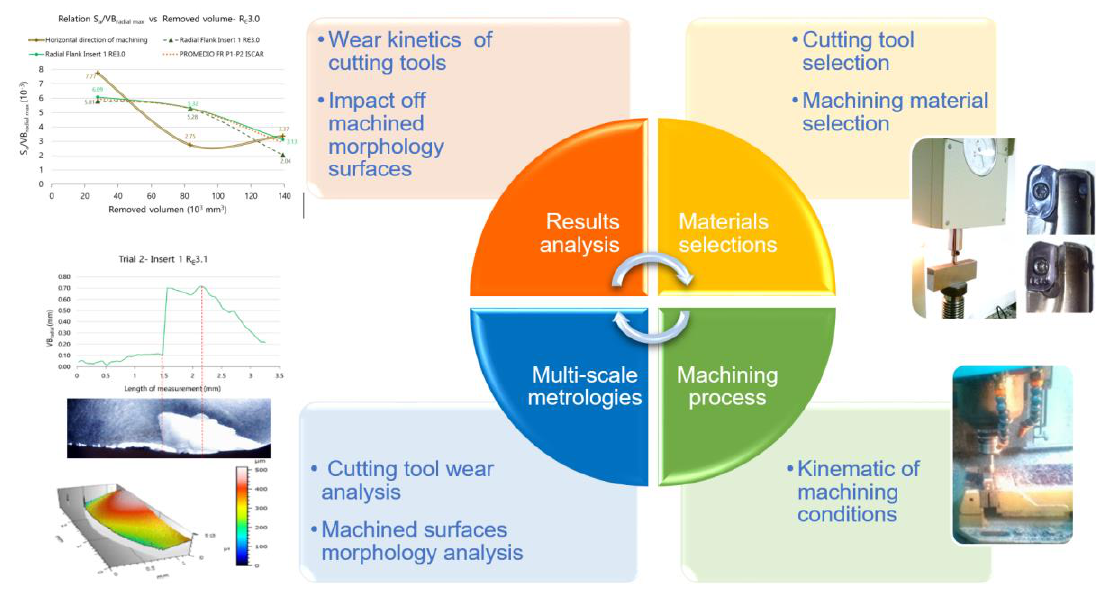
Figure 3. Experimental procedure.